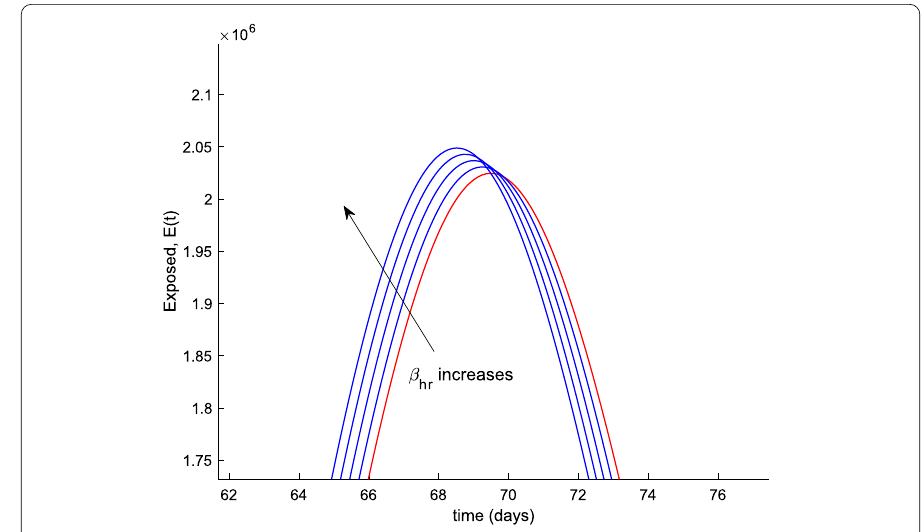
Figure 5 Zoom on the variation of the number of exposed individuals with β hr in the absence of control actions